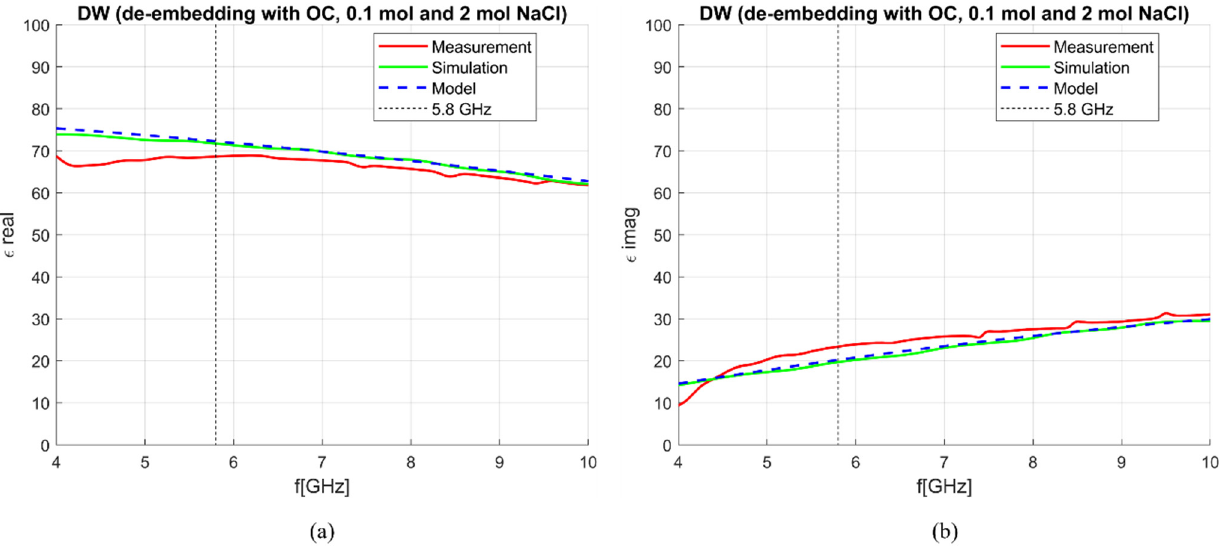
Figure 5. S&S de-embedding of DW with OC, 0.1 mol and 2 mol NaCl; comparison between simulations and measurements: ( a ) ε ’; ( b ) ε ’’.